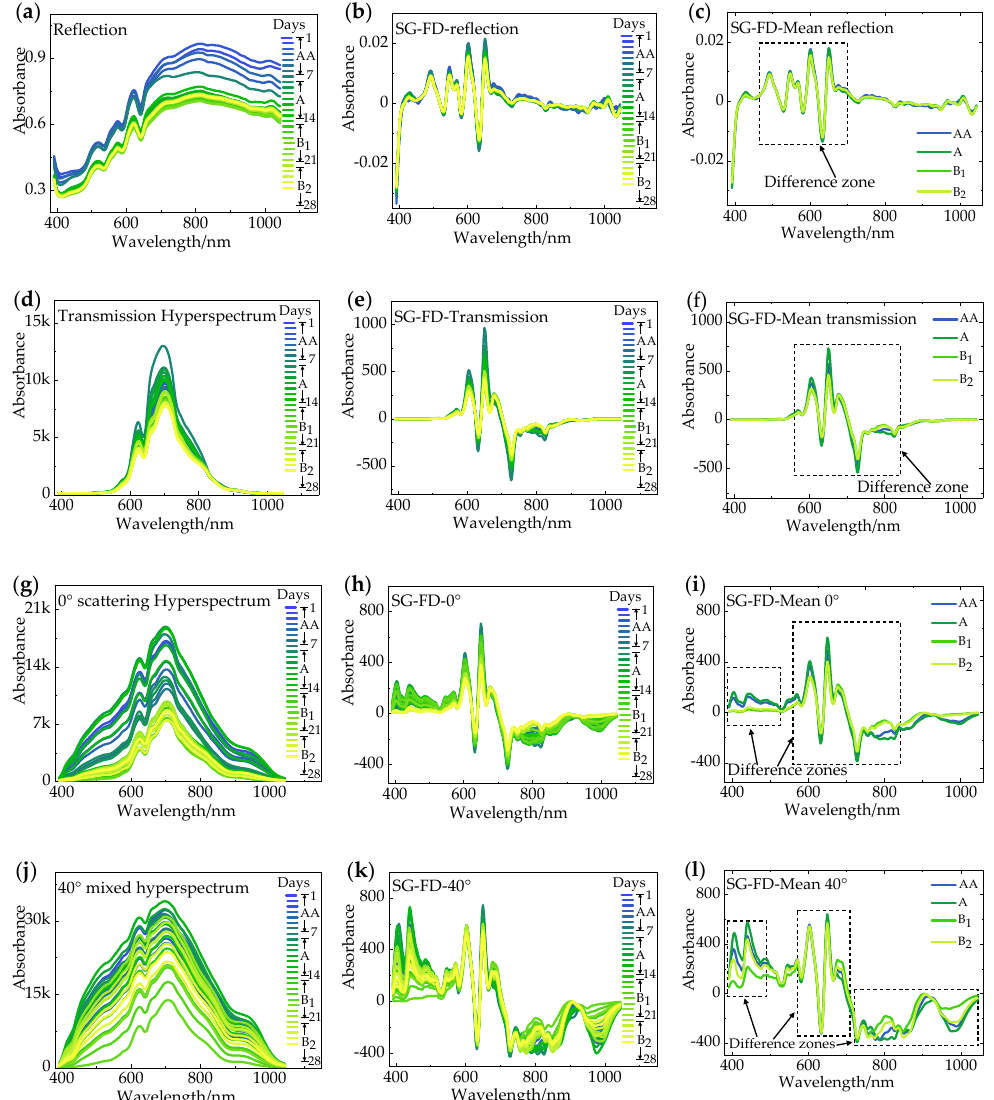
Figure 5. Savitsky–Golay first derivative (SG-FD) pretreatment. ( a , d , g , j ) The average hyperspectral of eggs per day from 1 to 28 days as incident light are reflection, transmission, 0° scattering, and 40° mixed spectra, respectively; ( b , e , h , k ) Corresponding spectra after SG-FD treatment; ( c , f , i , l ) The average spectra of Grade AA, A, B 1 , and B 2 after SG-FD treatment, respectively.